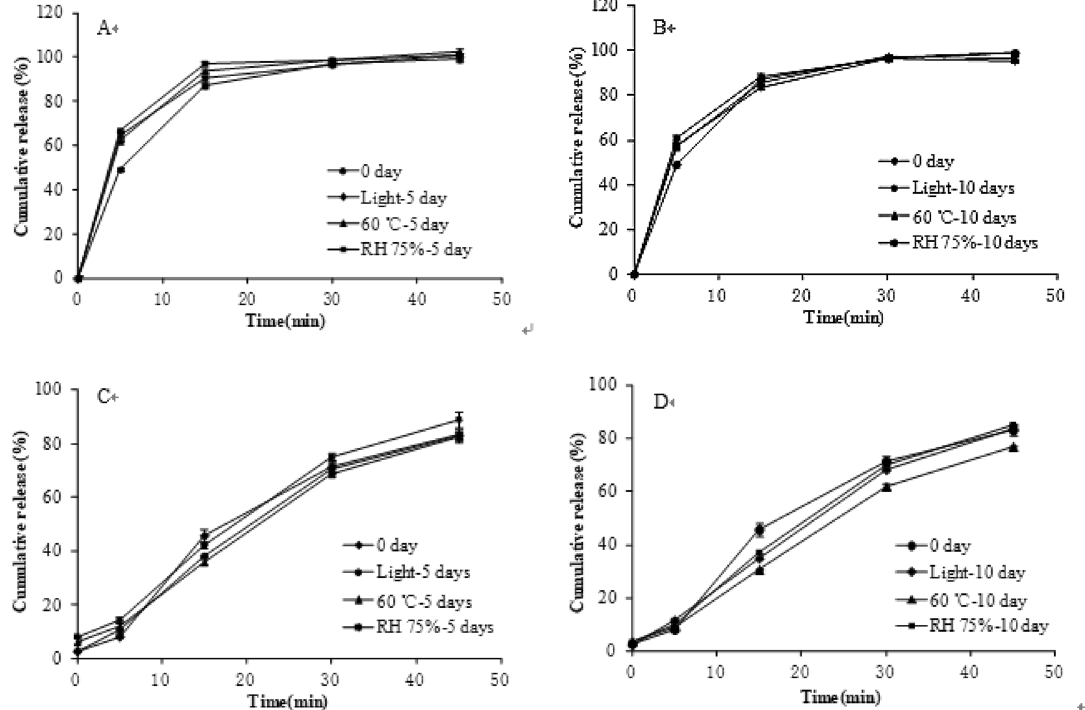
Fig. 6 The stress testing results of cumulative release of compound enteric-coated granules ( A , B release of L-glutamate; C , D release of